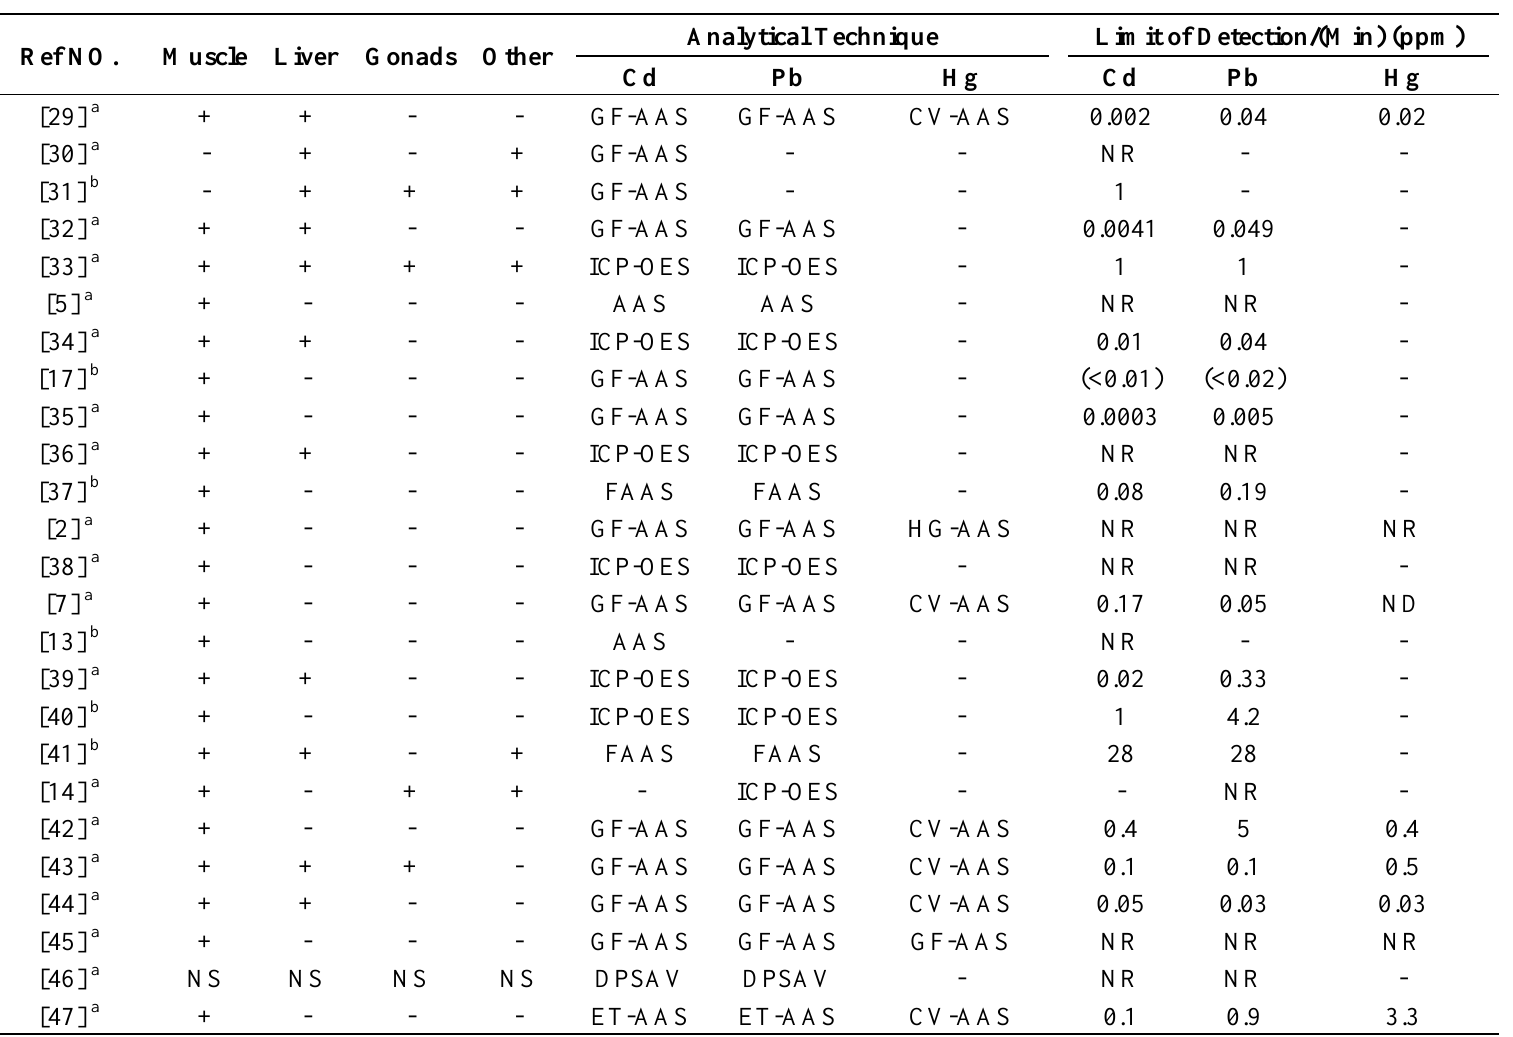
Table 2. Analytical techniques applied in the reviewed